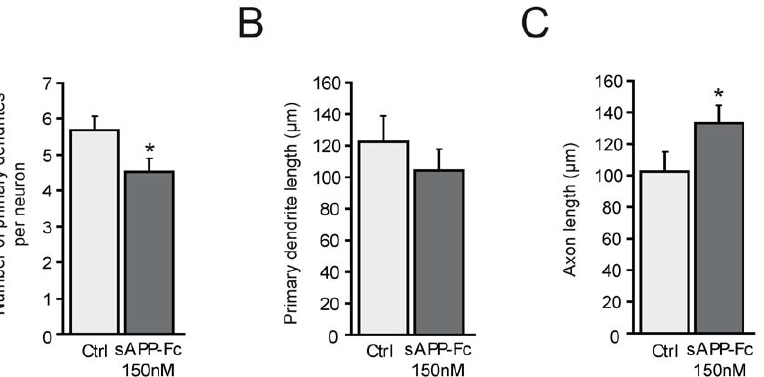
Figure 2. Changes in neuronal morphology after 150 nM sAPP-Fc added to 5DIV neurons. Morphometric analysis 96 hours after the addition of 150 nM sAPP-Fc to 5DIV neurons shows that: ( A ) sAPP-Fc induces a significant decrease of primary dendrite number (control (Ctrl) vs sAPP-Fc: p , 0.0276). ( B ) sAPP-Fc does not modify primary dendrite length (control vs sAPP-Fc: NS). ( C ) sAPP-Fc induces an increase of axon elongation (control vs sAPP-Fc: p , 0.0297). The data in A-C are the mean of 3 independent experiments. Statistical analysis was done with ANOVA and Scheffe’s post-hoc test.